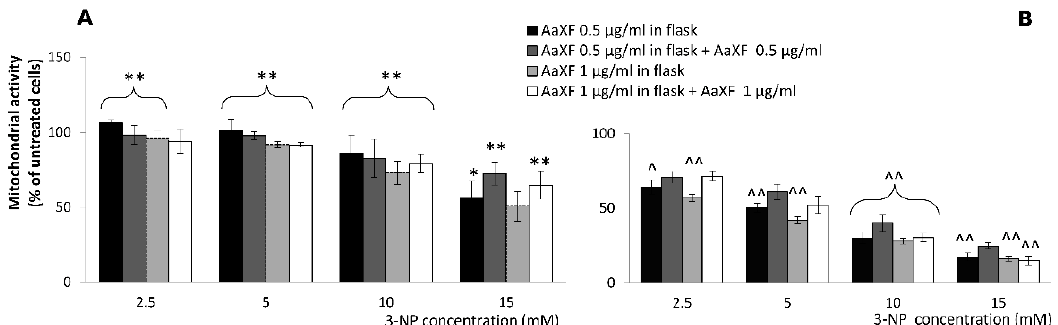
Figure 4. Mitochondrial activity of PC12 cells after pre-incubation of XF (0.5 or 1 μ g/mL) in cell culture flasks for at least 48 h, which were treated with 3-NP (2.5, 5, 10 and 15 mM) with the absence or presence of very low concentrations of XF (0.5 and 1 μ g/mL) for 8 h ( A ) and 24 h ( B ). The mitochondrial activity of cells was measured using a 3-(4,5-dimethylthiazol-2-yl)-2,5-diphenyl tetrazolium bromide (MTT) assay. The data represent the mean ± SD of cell viability in five independent experiments. Significantly higher from the corresponding 3-NP treatments group at * p < 0.05 or ** p < 0.005 and significantly lower from the corresponding 3-NP treatments at ^ p < 0.05 or ^^ p < 0.005.